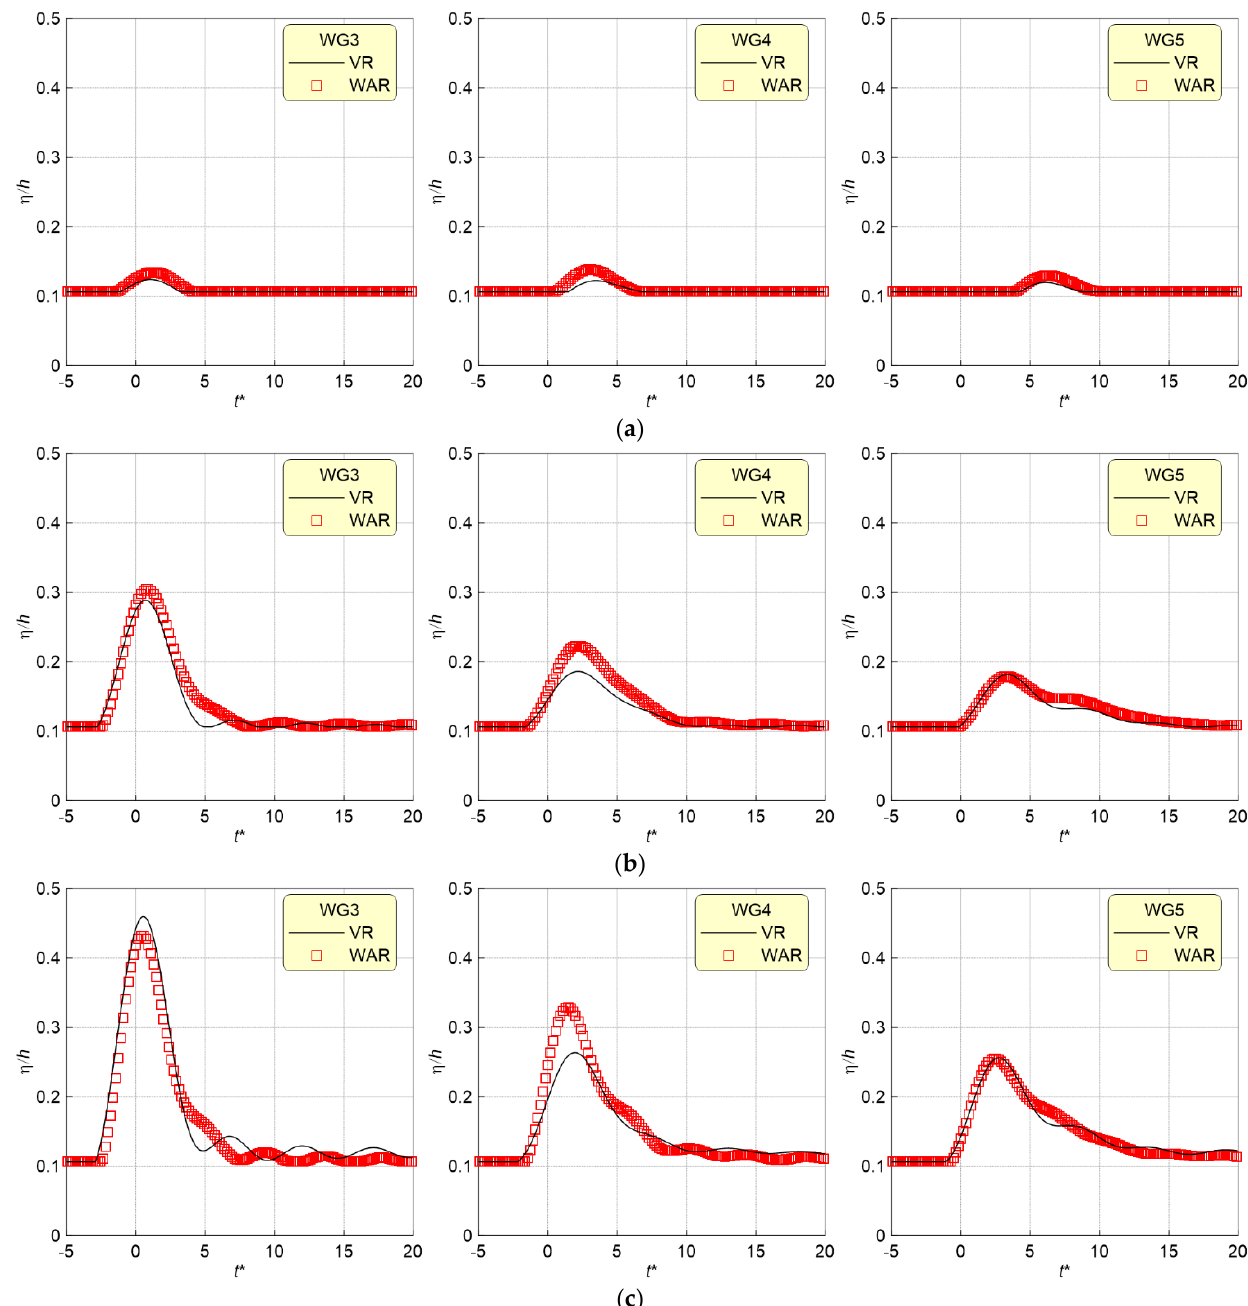
Figure 5. Comparisons of water surface elevations at WG3, WG4, and WG5 for the VR and WAR: ( a ) Run-1 ( 𝐴 0 = 4.4 cm , 𝜀 = 0.09 ); ( b ) Run-7 ( 𝐴 0 = 12.3 cm , 𝜀 = 0.26 ); ( c ) Run-11 ( 𝐴 0 = 21.5 cm , 𝜀 = 0.46 ).